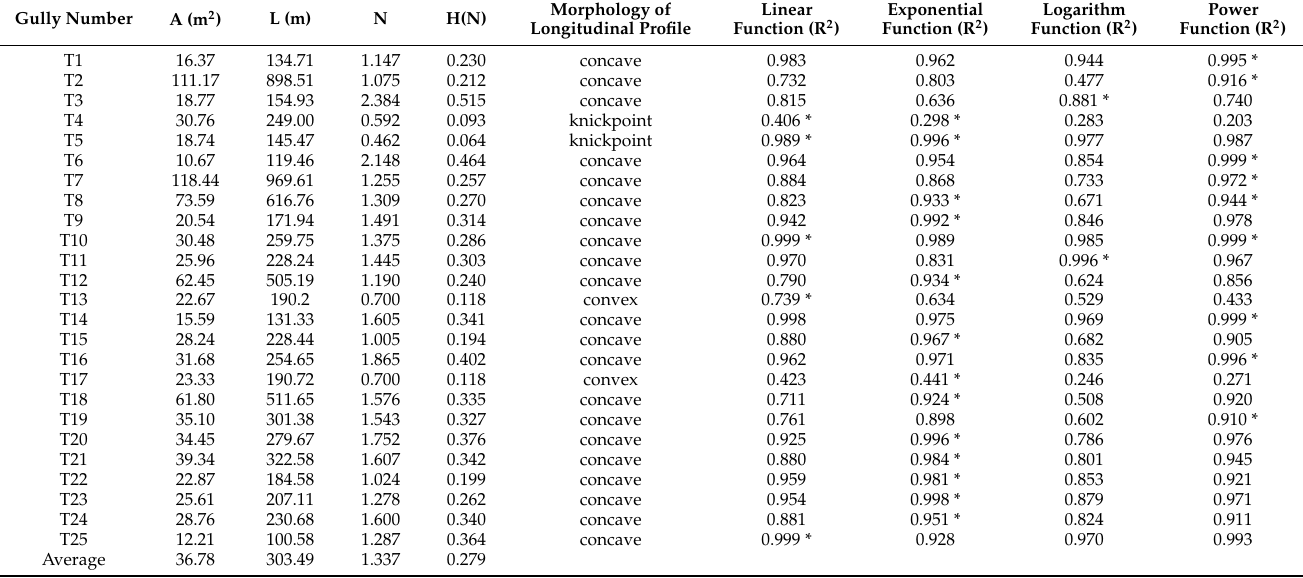
Table 2. The gully index of Tutujiliangzi and the optimum-fit